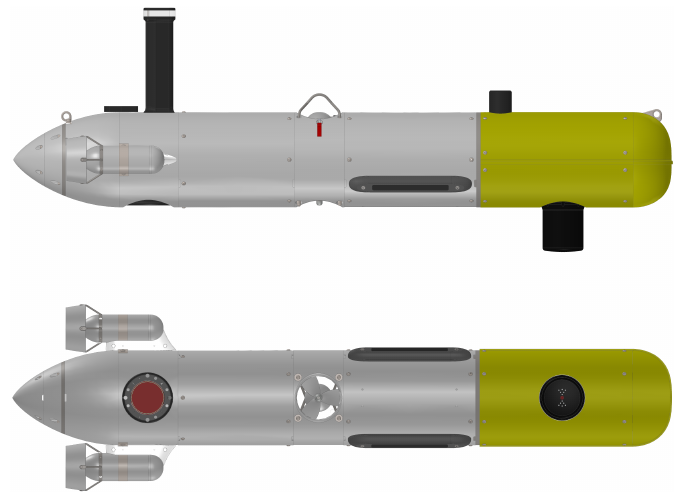
Figure 7. Sparus II AUV side view ( up ) and bottom view ( bottom ). Profiler is mounted on the payload area (in yellow) at the bottom of the